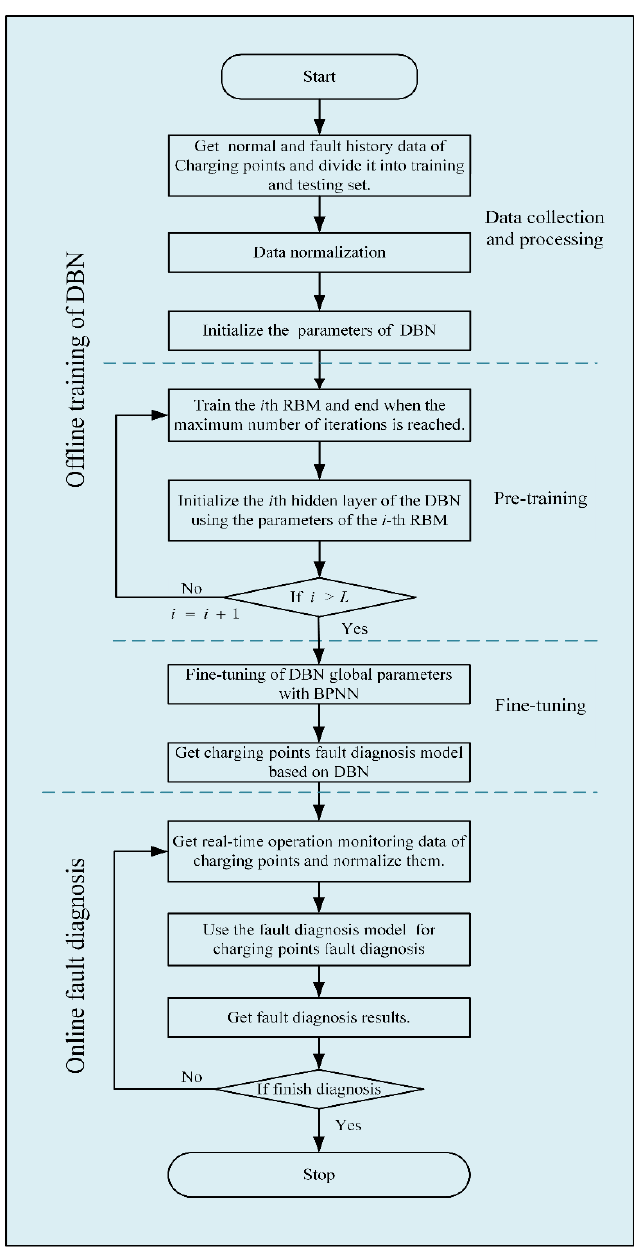
Figure 4. Fault diagnosis flow based on DBN.